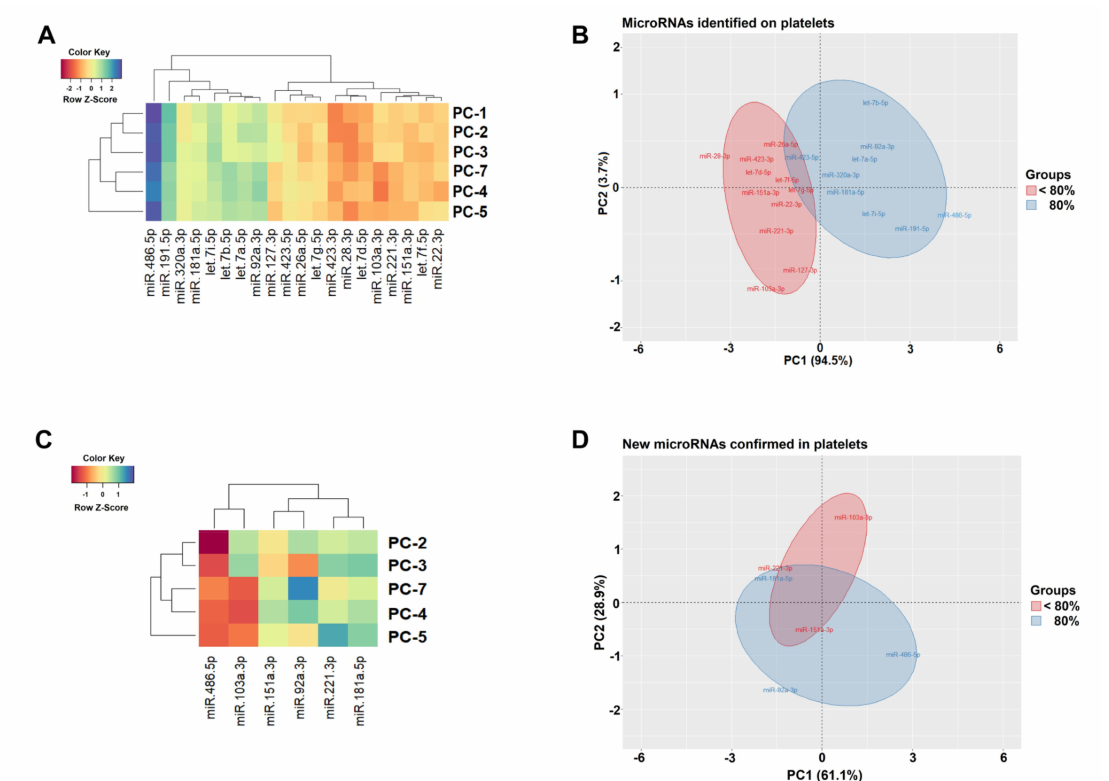
Figure 4. Hierarchical cluster ( A ) and principal component analysis (PCA) ( B ), generated with sRNA-Seq data. Hierarchical cluster ( C ) and PCA ( D ) generated with the validation data by